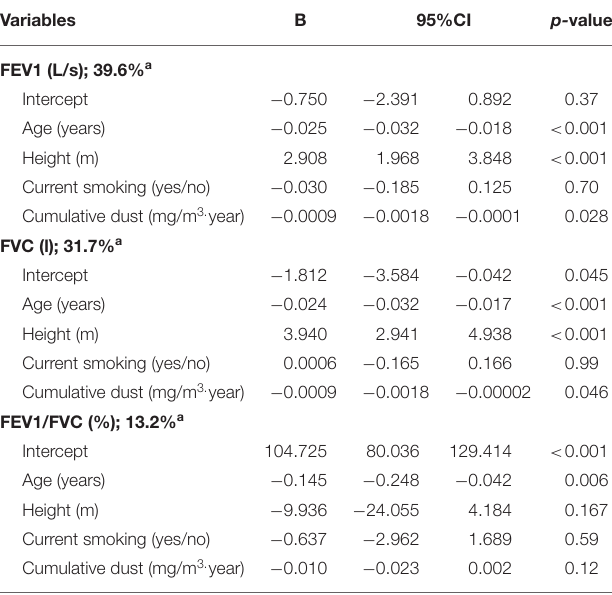
TABLE 5 | Linear mixed effects models for the association between cumulative dust exposure and three lung function variables among 239 male coffee workers in Tanzania and Ethiopia (random effect;